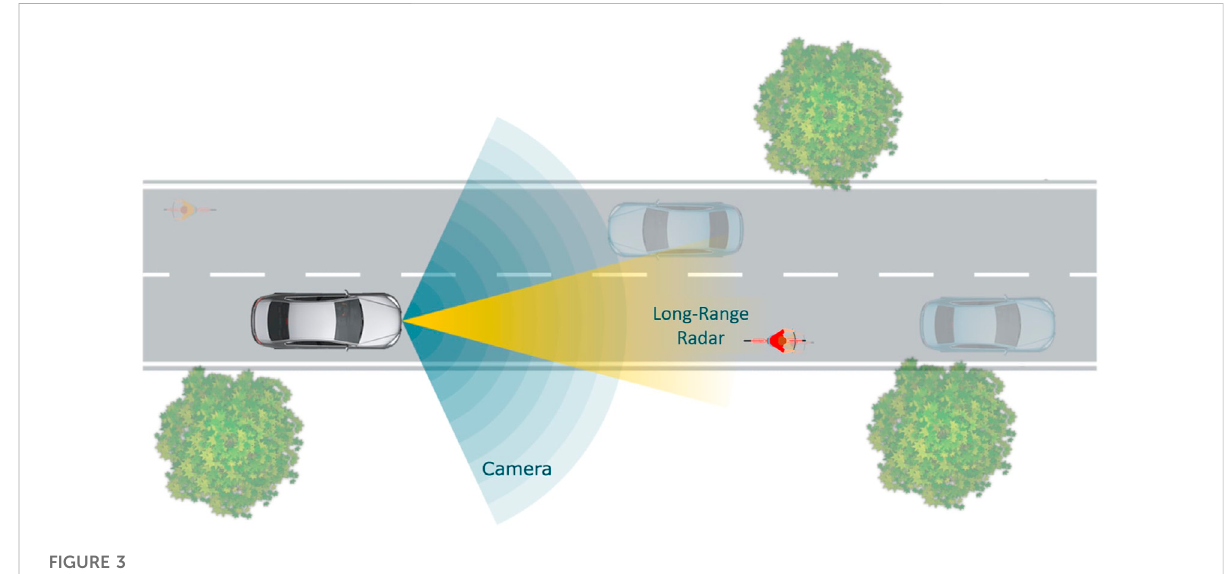
FIGURE 3 The sensor layout of the autonomous agent used in this